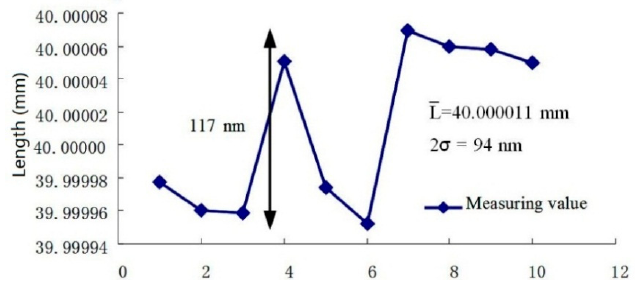
Figure 11. The measuring length of a gauge block with the nominal length of 40 mm.